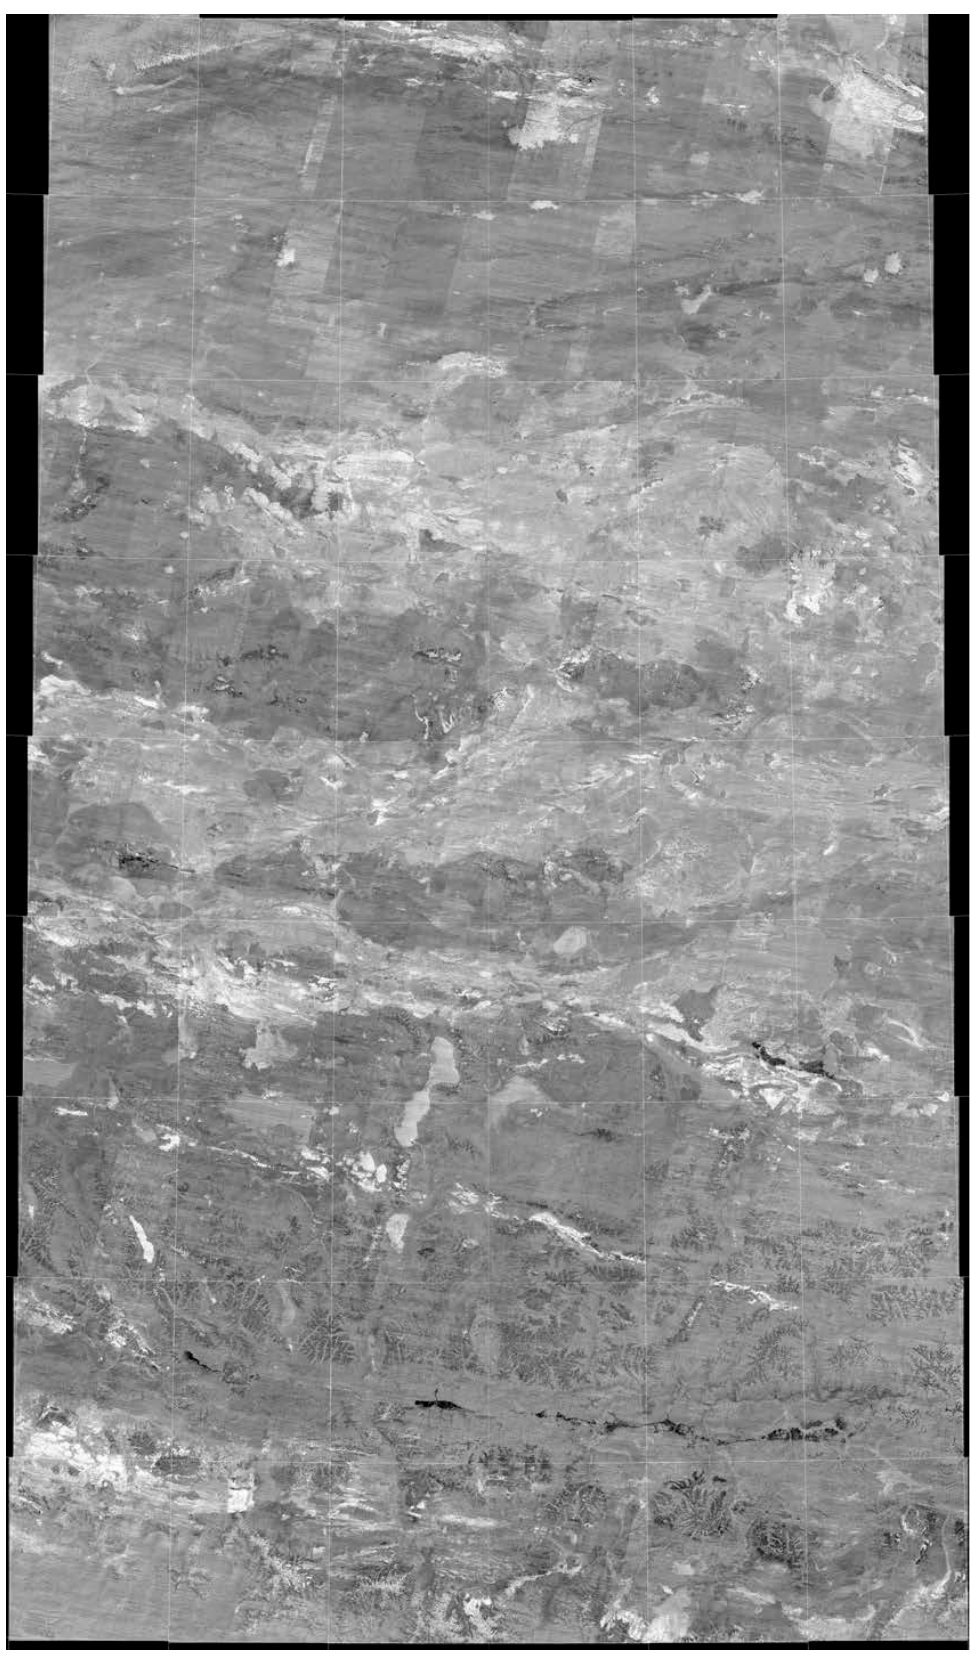
Figure A4. High resolution version of Figure 5b without annotated information.